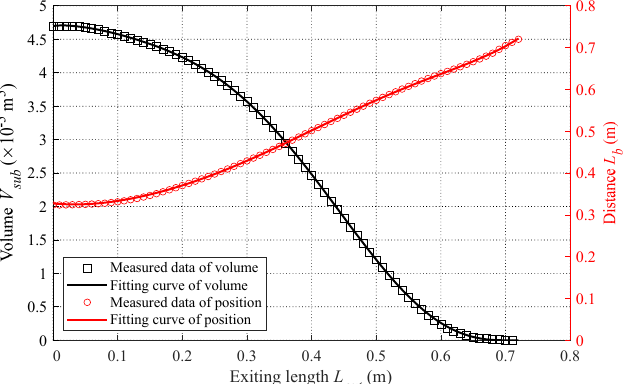
Figure 6. Volume and position of the CB of the submerged body under different exiting